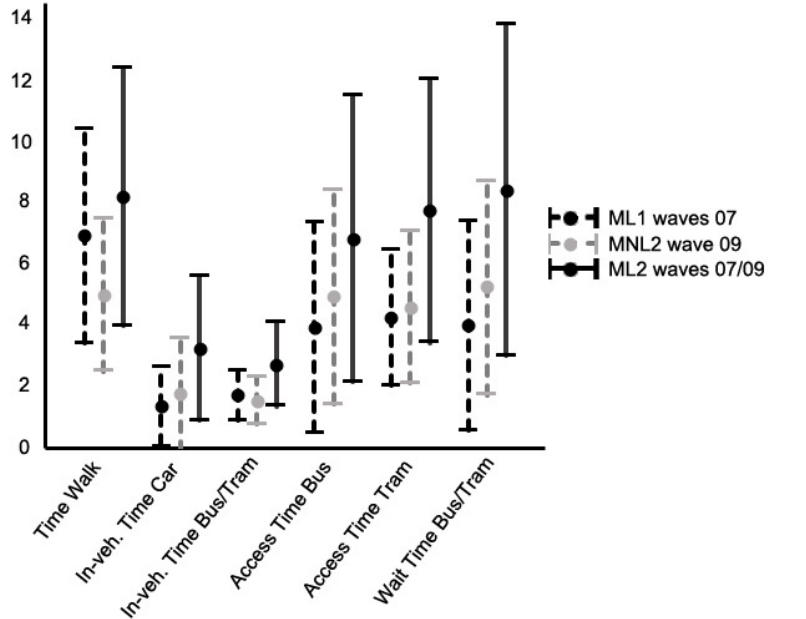
Figure 4. Point estimates and 90% confidence intervals for VTTS (€/h) for ML1, MNL3 and